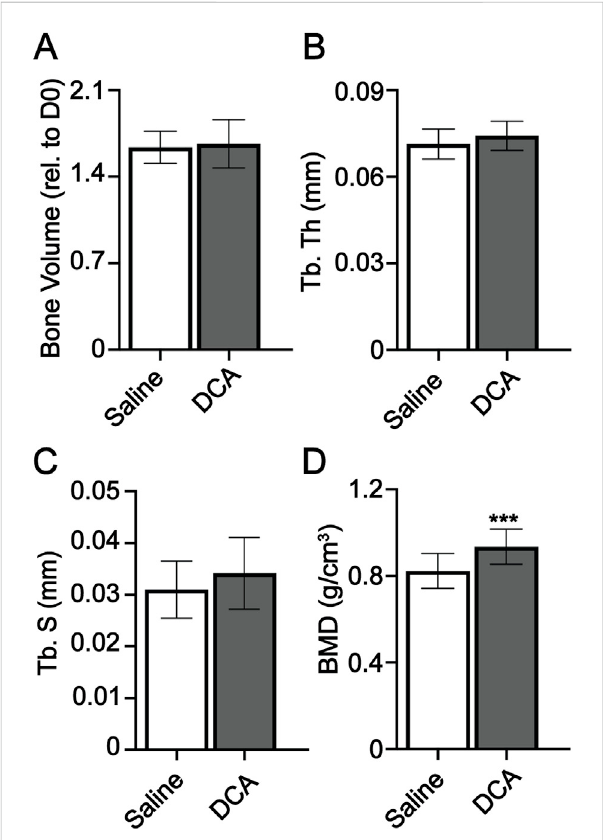
FIGURE 6 Dichloroacetate has no signi fi cant impact on digit regeneration. Micro-CT quanti fi cation of (A) bone volume (relative to day 0), (B) trabecular thickness (Tb. Th), (C) trabecular spacing (Tb. Sp), and